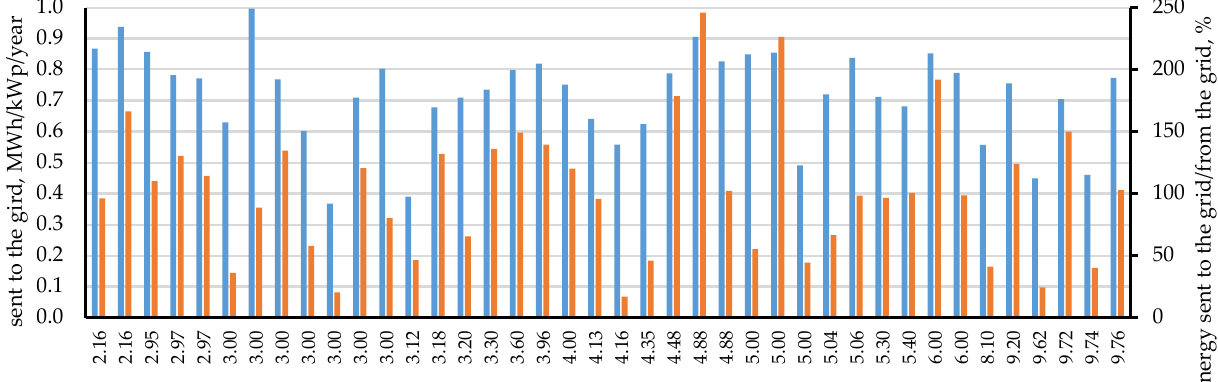
Figure 4. Annual values of energy sent to the grid in relation to the installed capacity and the annual share of energy sent to the grid in relation to the consumed, in the Kuyavian-Pomeranian province, 2019. Source: own study based on [32].